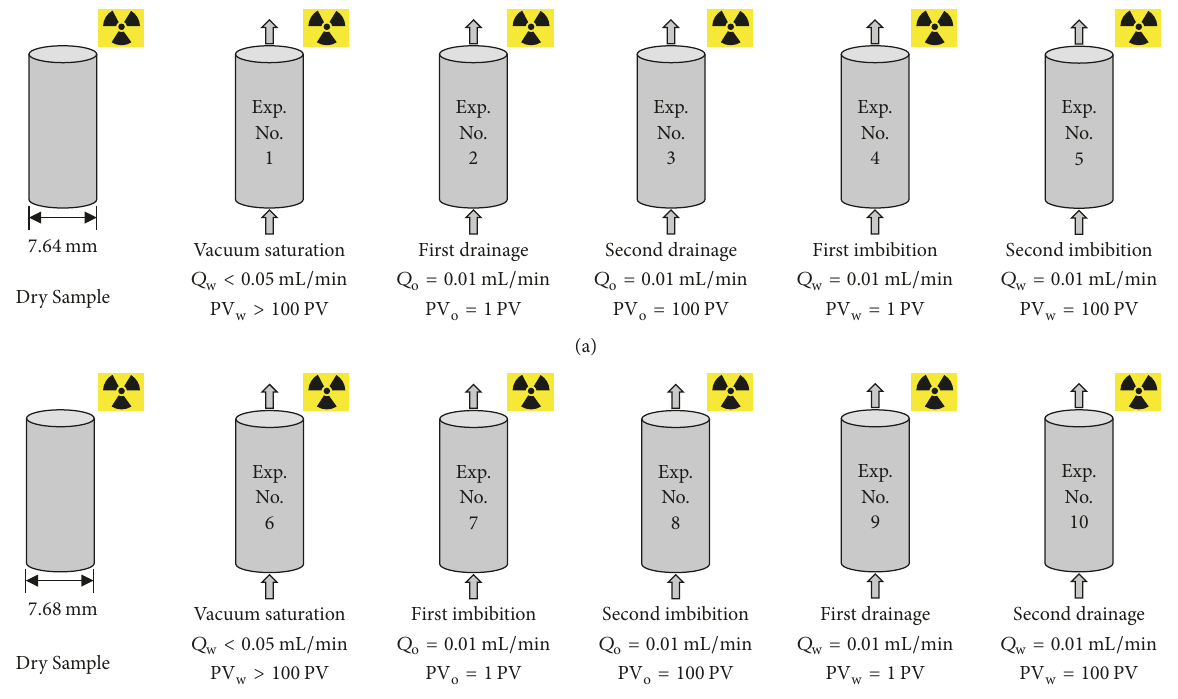
Figure 1: Schematic illustration of all experimental stages performed on (a) water-wet and (b) oil-wet plugs ( 𝑄 of brine and oil, resp.; PV